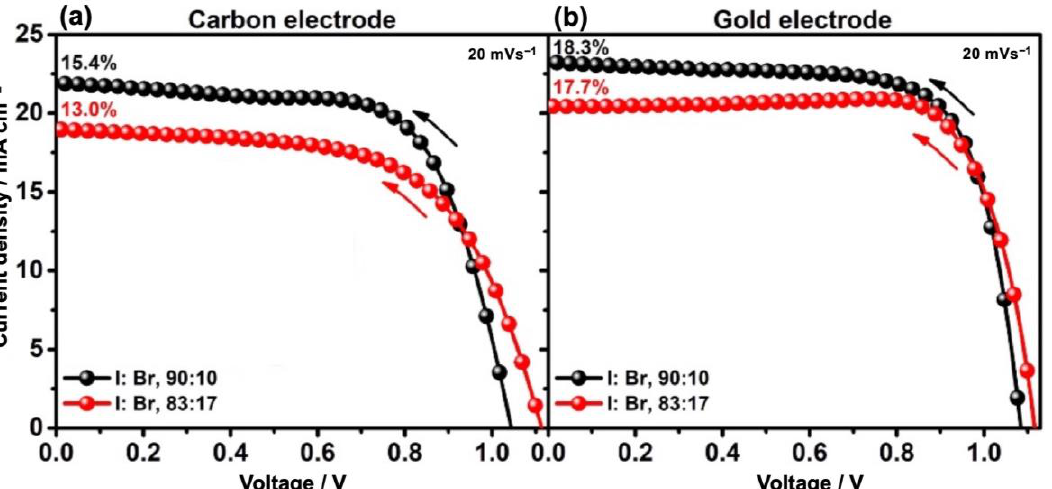
Figure 2. J-V curves of the champion perovskite devices with different back contacts. The CC embedded in carbon paste/spiro–OMeTAD cell ( a ) and spiro–OMeTAD/Au device ( b ). The backward J-V scan direction (at 20 mV s −1 scan rate) is shown by arrows. Table 1. The PV parameters of the champion devices with different back contacts (Au and carbon) and halide ratios. PCE (max) stems for the record efficiencies scanned in the backward direction and 20 mV s −1 scan rate.